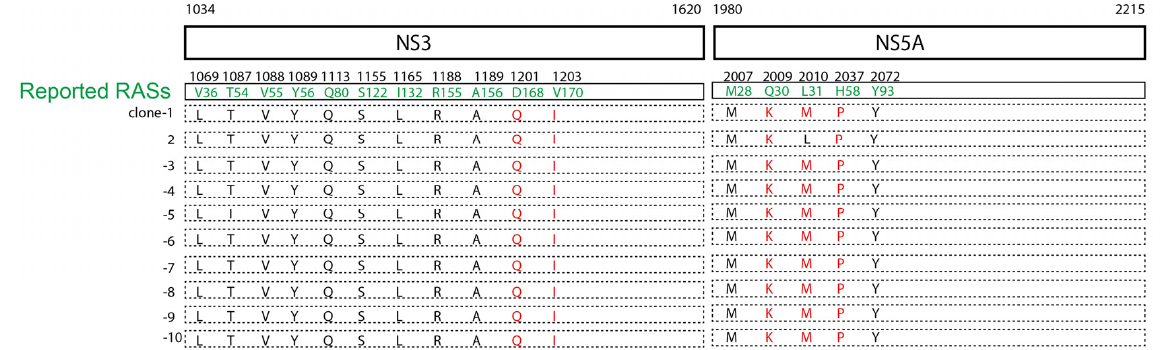
Figure 6. Resistance-associated substitutions (RASs) in the viral genome. The reported resistance- associated substitutions (RASs) are shown in the boxes, and their amino acid positions are shown above the boxes (green). The sequenced viral genomes are shown in the dashed boxes. The same amino acids as the reported RASs are shown in red.